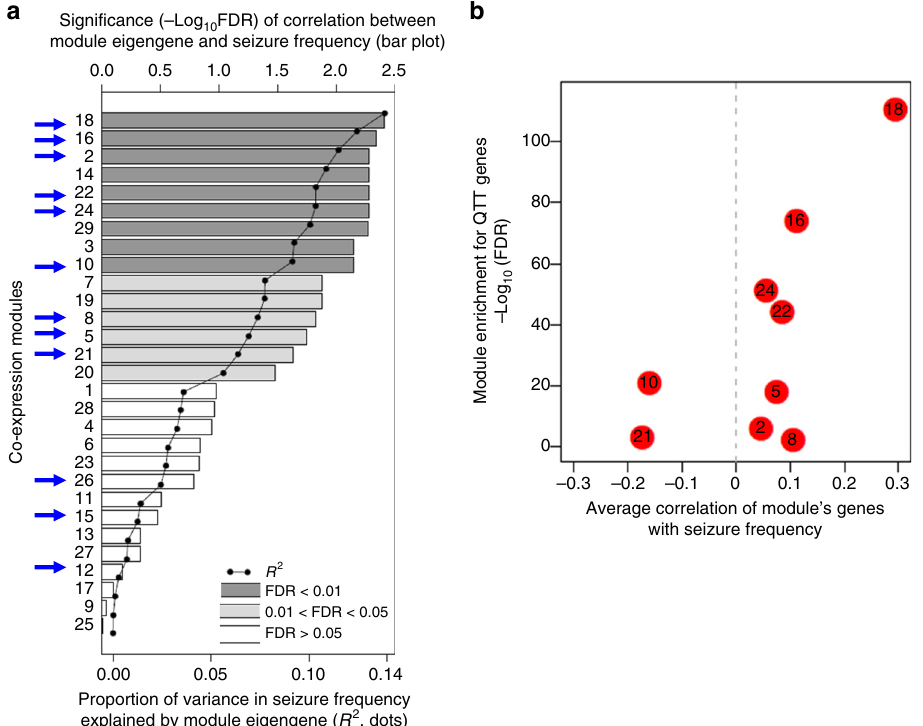
Fig. 2 Correlation of module expression with seizures. a For each co-expression module from the epileptic mouse hippocampus, we plotted the signi fi cance ( − Log 10 FDR) of the Spearman ’ s correlation between the module ’ s eigengene and seizure frequency (bar plot), and the percentage of variance in seizure frequency explained by the module ’ s eigengene ( R 2 , dotted line). Modules marked with a blue arrow are the modules differentially co-expressed between the epileptic mouse hippocampus and the control mouse hippocampus. Modules highlighted in gray (bar plot) are signi fi cantly (FDR <0.05) correlated with seizure frequency. b Volcano plot of average (Spearman ’ s) correlation of a module ’ s genes with seizure frequency ( X -axis) versus the signi fi cance of the module ’ s enrichment for genes individually correlated with seizure frequency (QTT genes) ( Y -axis) for the nine modules differentially co-expressed in epilepsy and correlated with seizures by module